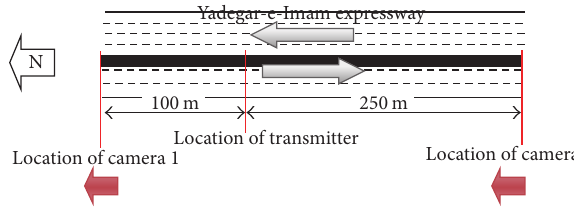
Figure 4: Location of cameras and the transmitter.